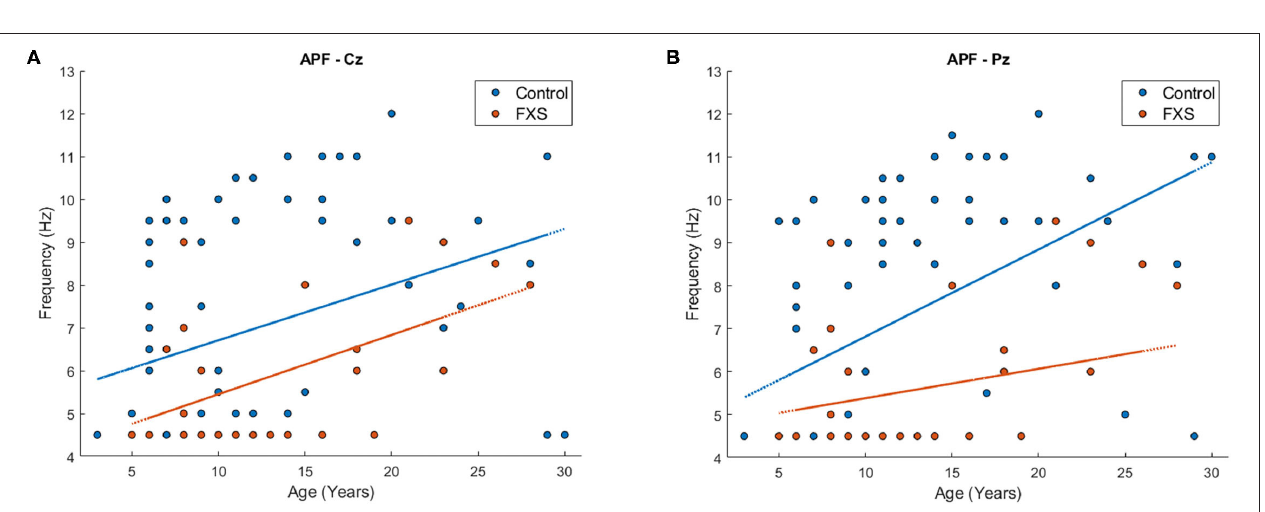
correlated negatively with age across all ROI in the whole sample ( p < 0.0001) and within both groups (FXS; p < 0.01, controls: p < 0.0001). A mixed design ANOVA controlled by age revealed main effects for ROI [ F (4.9,439.2) = 41.89, p <